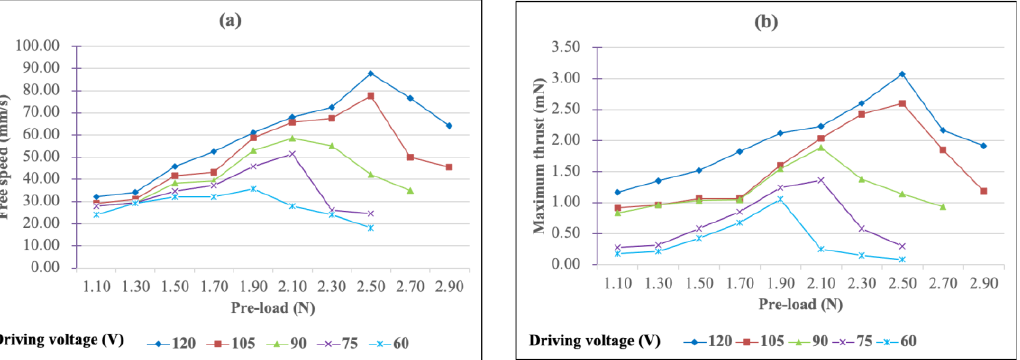
Figure 13. ( a ) Free speed and ( b ) maximum thrust figures as a function of pre-load for the simple bimorph USM under different driving voltages.